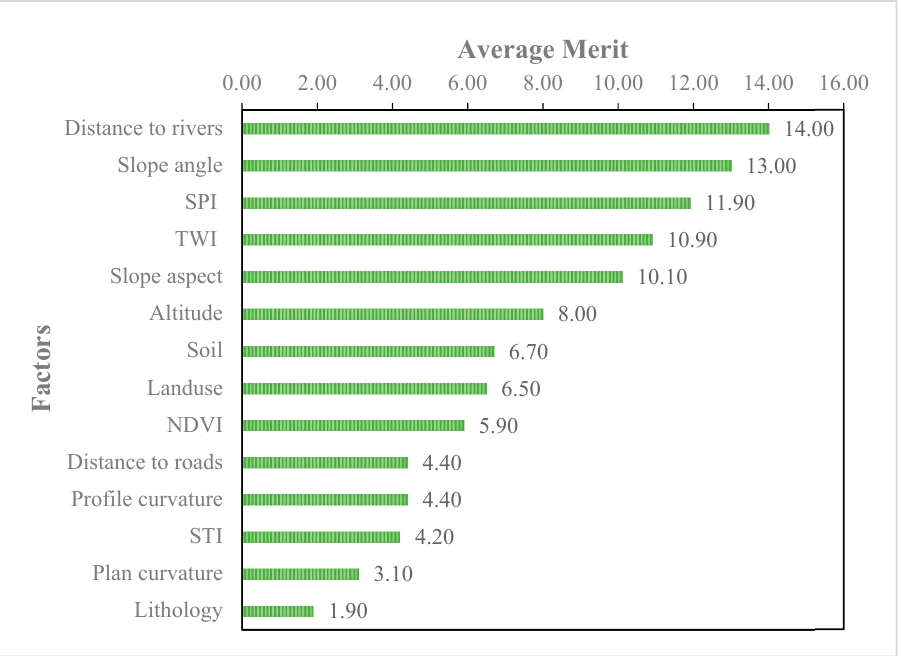
Figure 4. The prediction capability of landslide affecting factor s.